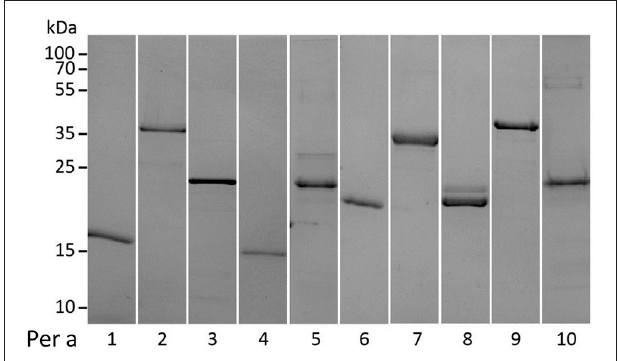
FIGURE 1 | SDS–PAGE and Coomassie staining of recombinant Periplaneta allergens, Per a 1 to Per a 10 (1-10), under reducing conditions.